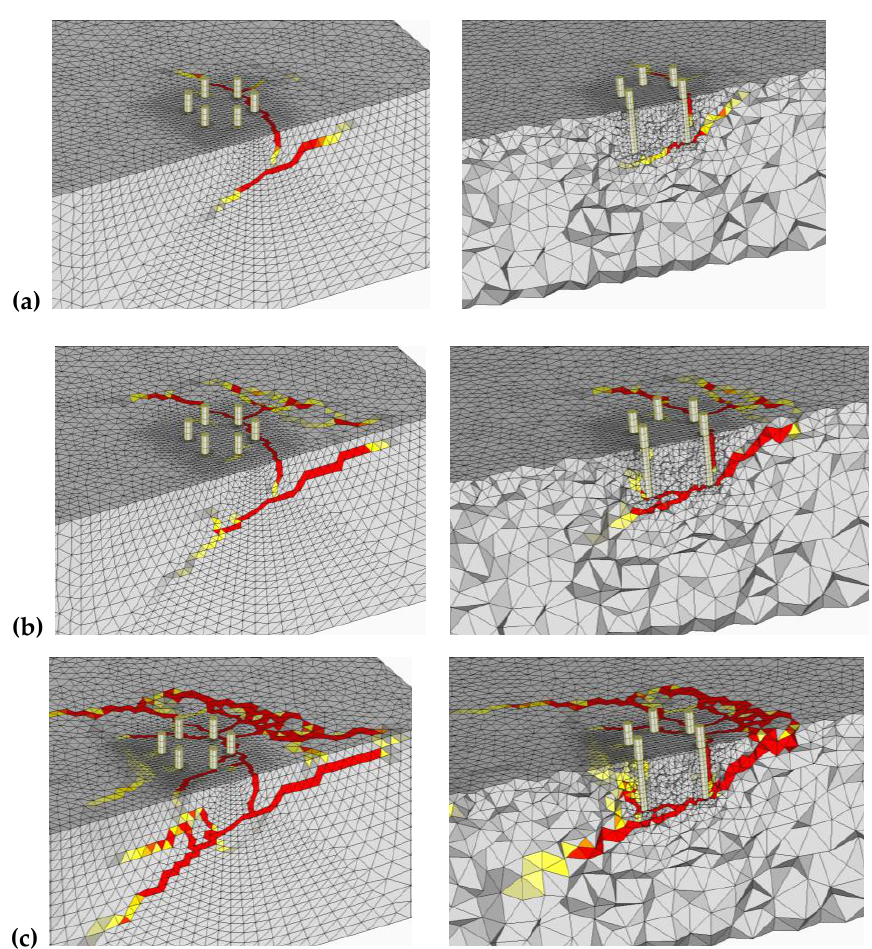
Figure 15. Crack pattern obtained from numerical analysis for Group Hex-B loaded parallel to the edge ( a ) first cracks, ( b ) at peak load, and ( c ) post-peak phase.